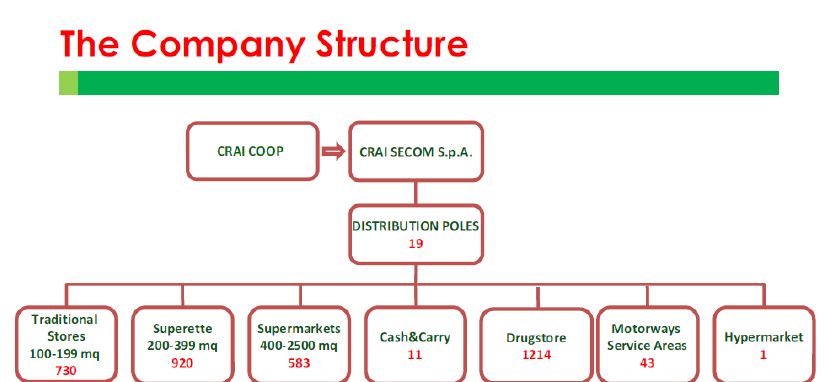
Figure 2: CRAI Company